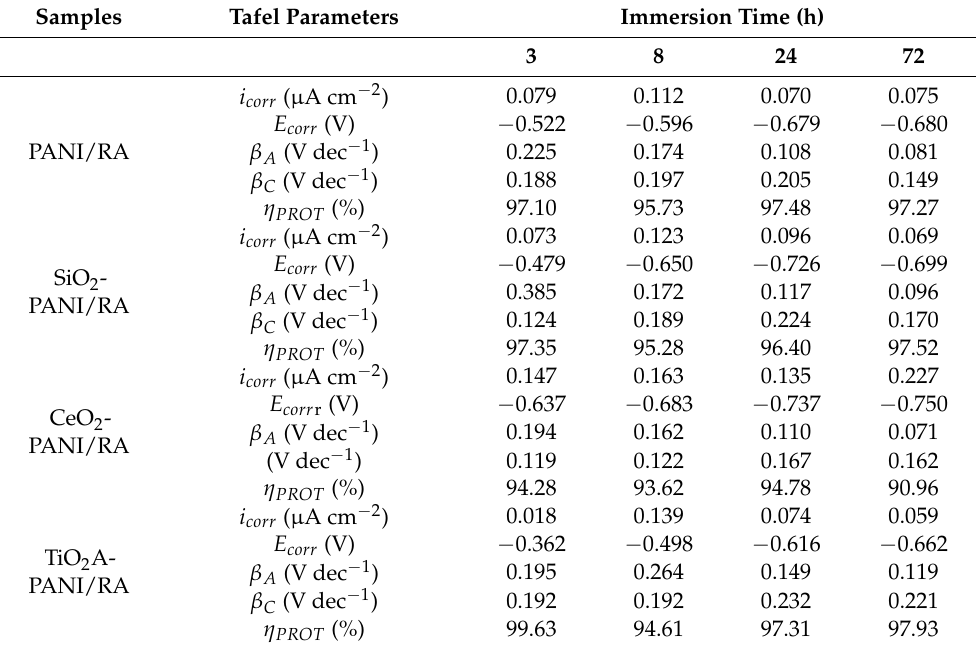
Table 3. Tafel parameters obtained for PANI-based coatings immersed in 3.5% NaCl solution for 3, 8, 24, and 72